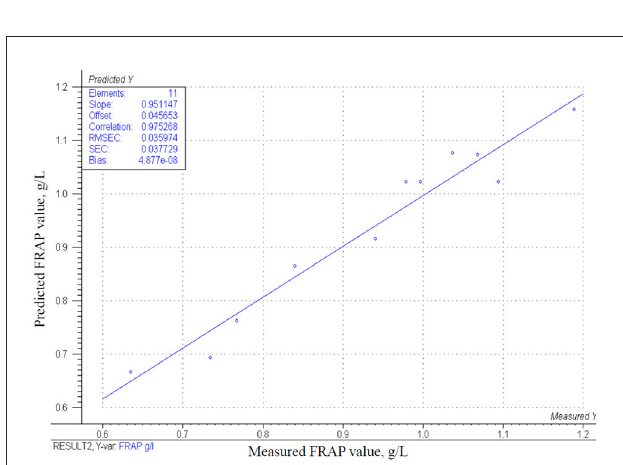
FIGURE7 Correlation of the obtained model and the measured results for the change in FRAP g/L.